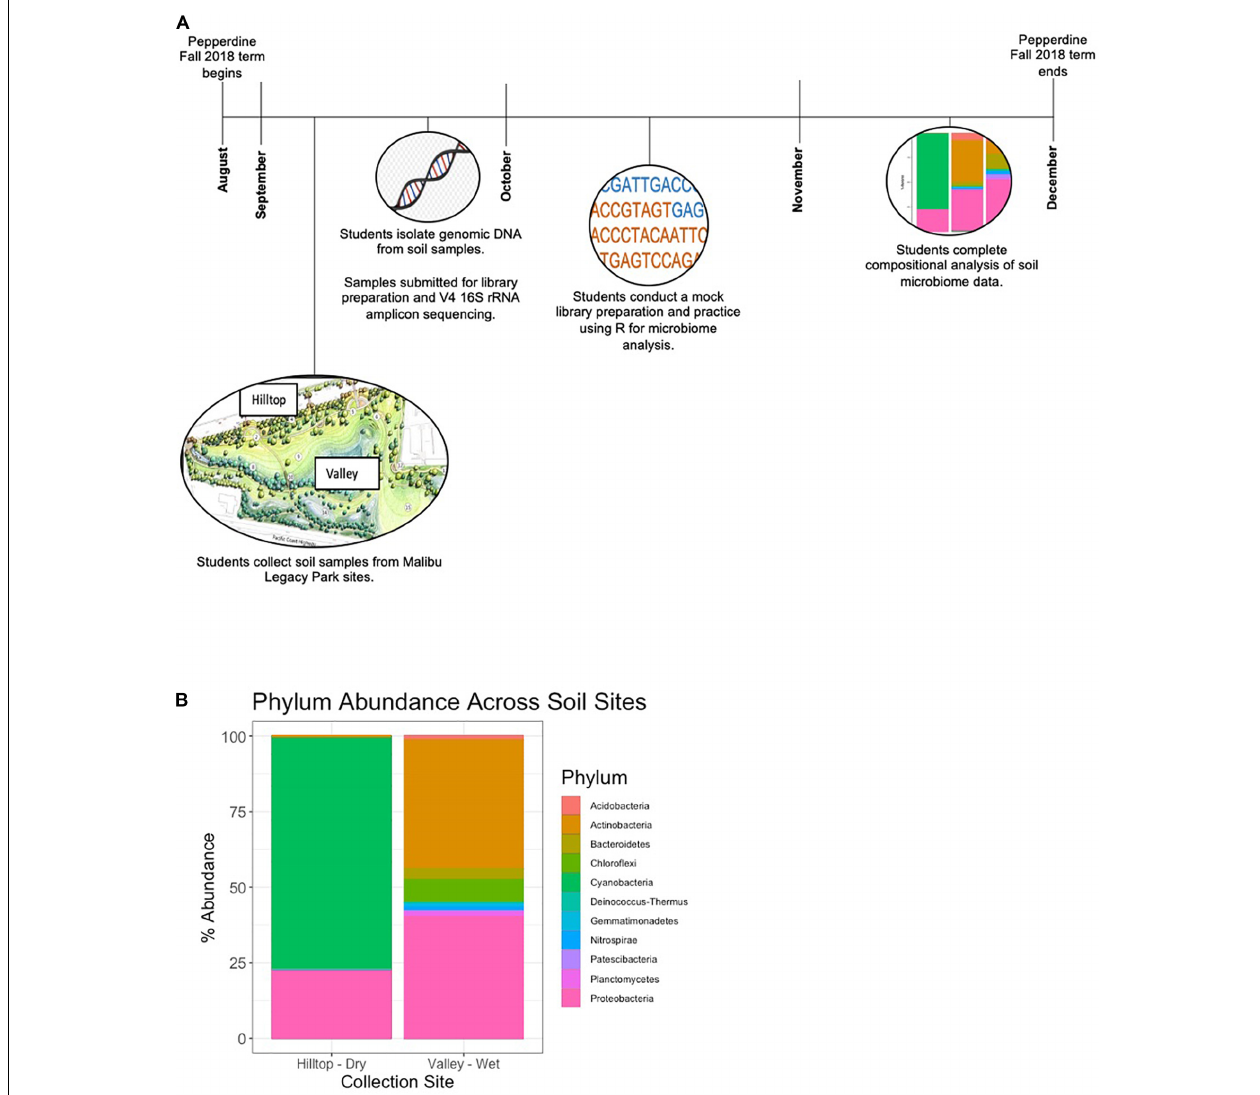
FIGURE 2 | Soil microbiome analysis. (A) Timeline of the student-led soil microbiome sequencing project. (B) Relative bacterial phylum abundances across Legacy Park